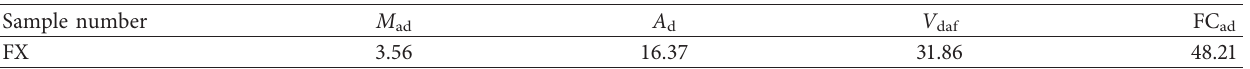
Figure 2: Physical drawing of the experimental device. Table 1: Industrial analysis of coal